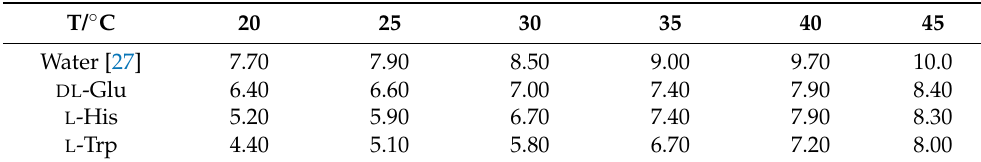
Table 1. Values of critical micelle concentrations, CMCs of SDS (mM) in water and 0.01 M aqueous solutions of Tryptophan, Histidine, and Glutamic acid at different temperatures obtained from conductometric